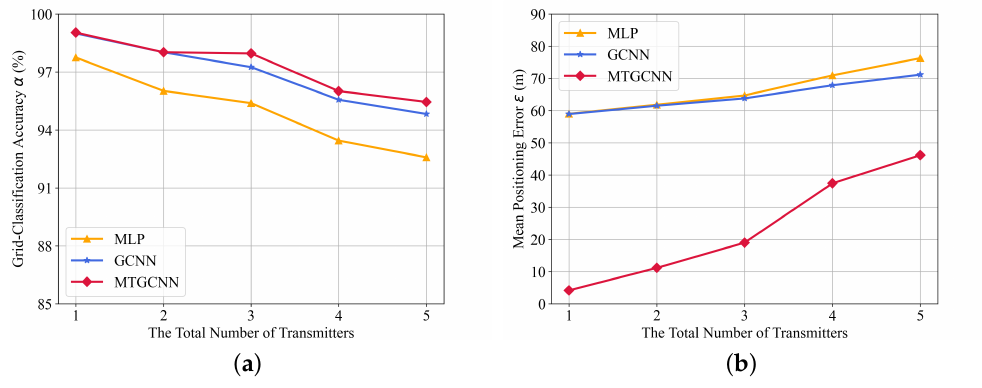
Figure 4. The localization results with a different number of transmitters. ( a ) grid-classification accuracy and ( b ) mean positioning error.